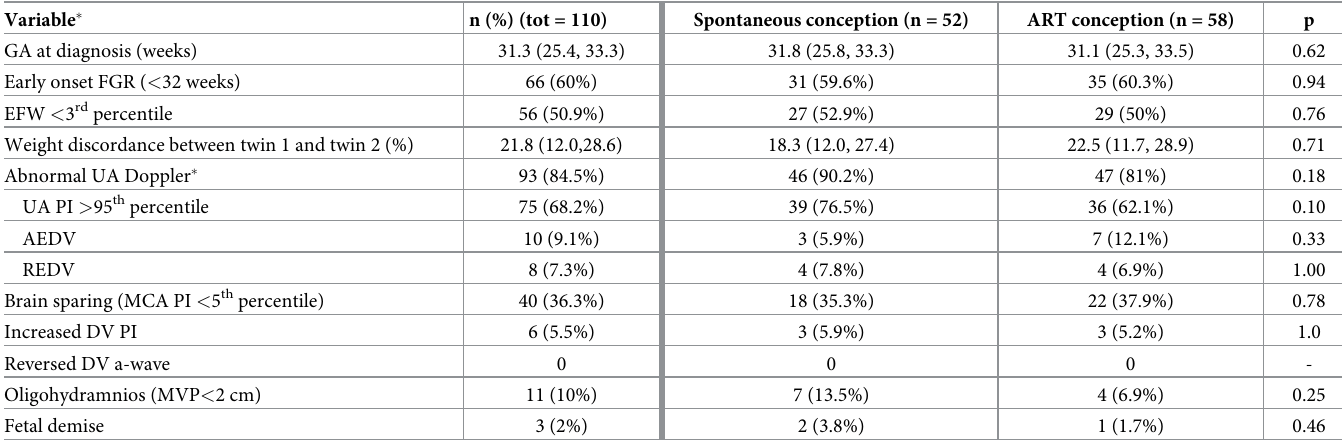
preeclampsia. Since 14 pregnancies had FGR of both fetuses, the total number of fetuses with an ultrasound diagnosis of FGR was 110 (8.1% of all fetuses). The incidence of FGR was not significantly different between the IVF/ICSI group and the SC group (7.9% vs 8.4% respec- tively, p = 0.76, aOR 0.84, 95%CI 0.53–1.32). The ultrasound characteristics and frequency of Doppler abnormalities of the 110 fetuses with diagnosis of FGR are reported in Table 4. Sixty per cent of cases of FGR had early onset ( < 32 weeks), and the most frequent Doppler abnor- mality observed was an increase in umbilical artery (UA) pulsatility index (PI). Fetal demise of the FGR fetus occurred in three cases. Of these, two had absent end-diastolic velocity (AEDV), and one had reversed EDV (REDV) in the UA. All three cases had very early onset ( < 26 weeks) FGR, oligohydramnios and an EFW < 3 rd percentile. When the ultrasound Table 4. Ultrasound characteristics of FGR cases (n =